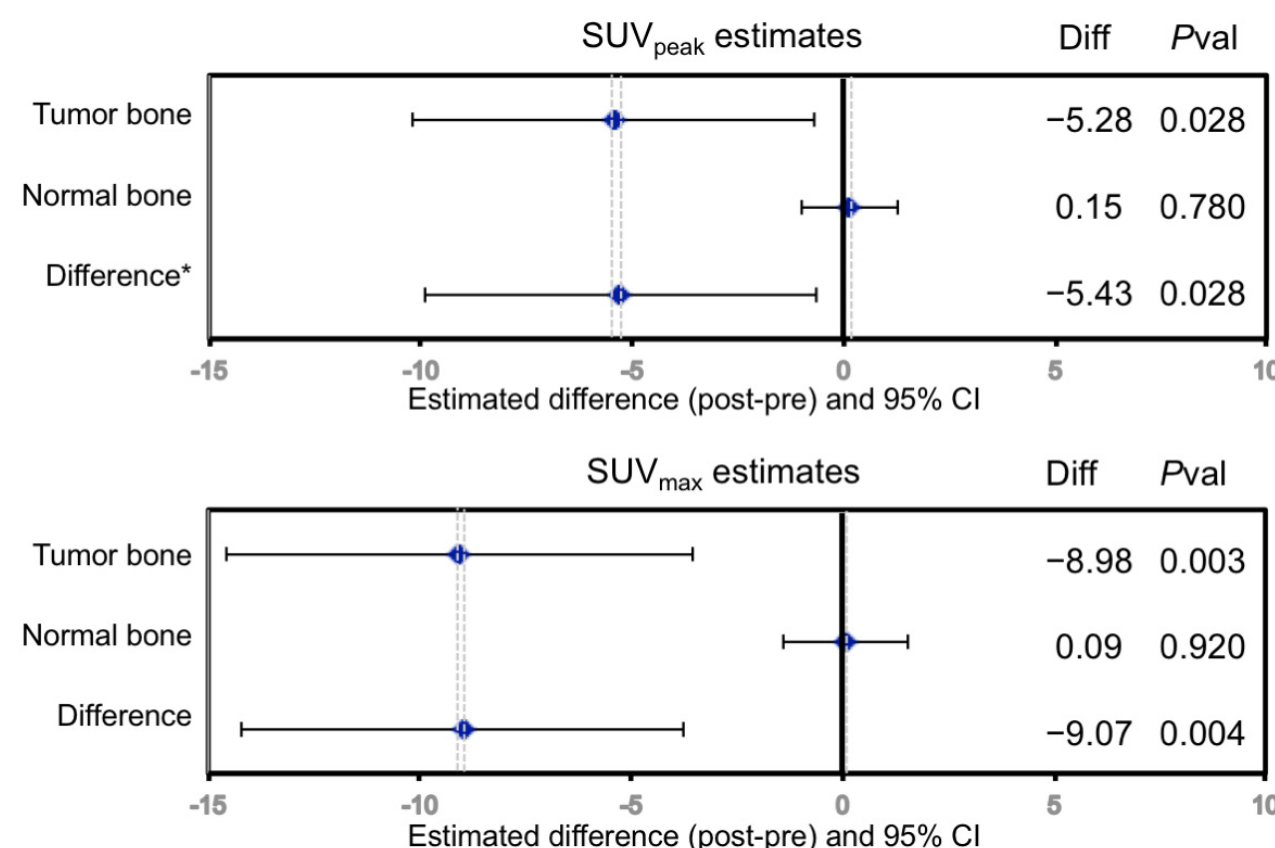
Figure 2. Change in regional 18 F uptake in response to dasatinib treatment in mCRPC bone metastases measured by SUVpeak, SUVmax. No significant changes were seen in normal bone. Diff = Scan2—Scan1; P val = p -value. * Difference = ∆ in tumor bone— ∆ in normal bone. Table 2. [ 18 F]-Fluoride uptake parameters in bone tumors.